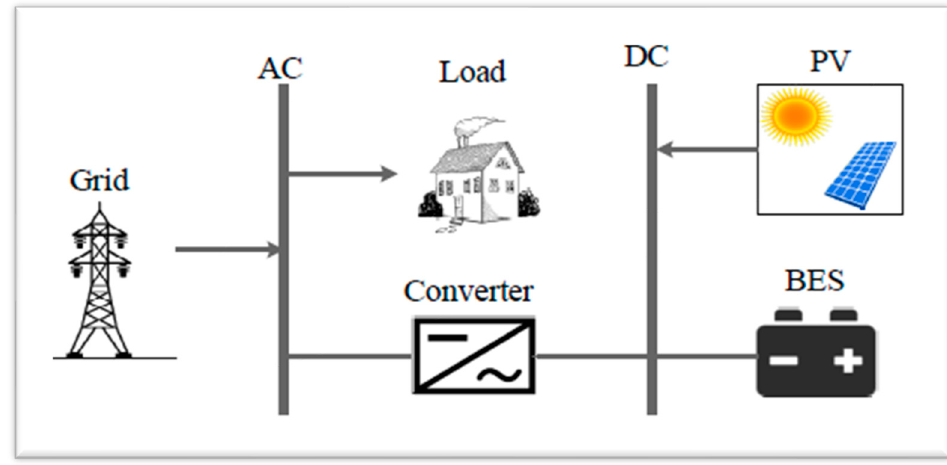
Figure 15. System 2: Grid-connected load with RES Based ad-hoc MG Backup.